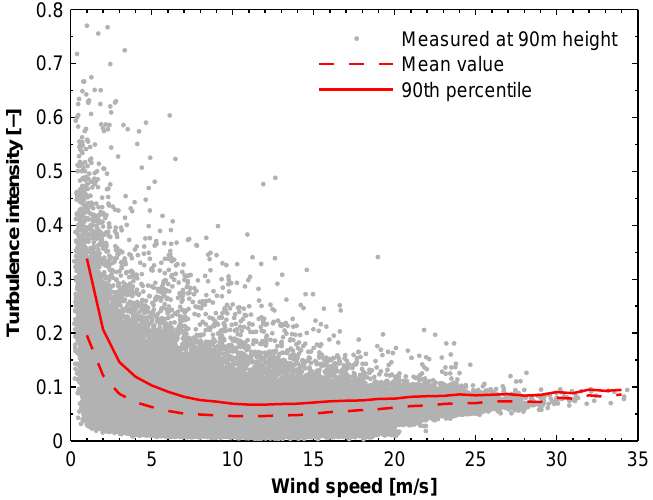
Figure 3. Measured turbulence intensity depending on wind speed at FINO 1 at 90